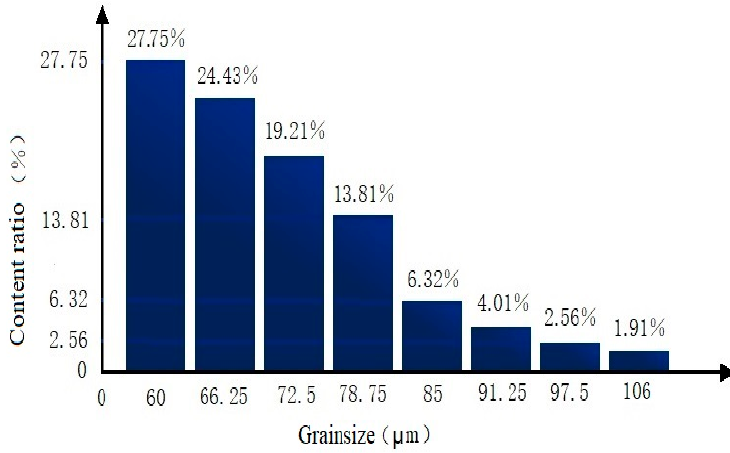
Figure 8. Percentage of particles with different sizes on the upstream.